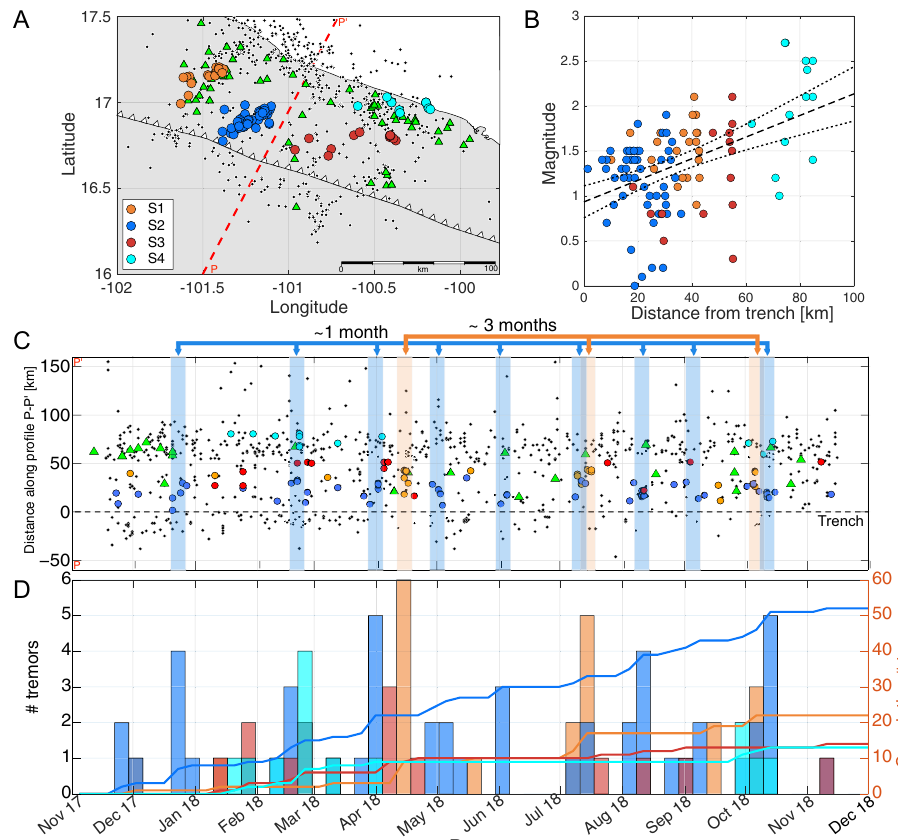
Fig. 2 Tremor clustering. A Distribution of STs (circles) into four main clusters S1 – S4. Green triangles and black circles are repeaters and earthquakes, respectively. Red dash line is pro fi le PP ’ . B Magnitude vs distance from the trench. Solid and dashed lines are the best linear fi t and its uncertainty, respectively. Colours and symbols as in A . C Time plot vs distance along pro fi le P-P ’ in A . Black dashed line is the location of the trench. Coloured areas are ST episodes in clusters S1 and S2. Colours and symbols as in A , showing only events occurring during 2017 – 2018. D Weekly histogram (left axis) and cumulative number of ST in each cluster (right axis). Colours as in A